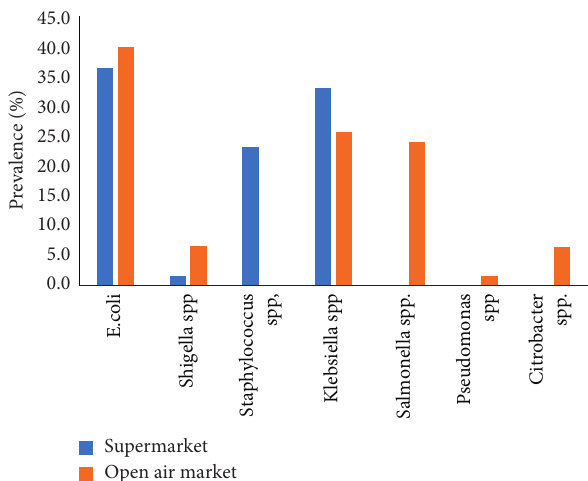
Klebsiella spp. Salmonella spp. Staphylococcus spp. ∗ Values in parentheses indicate the % incidence.